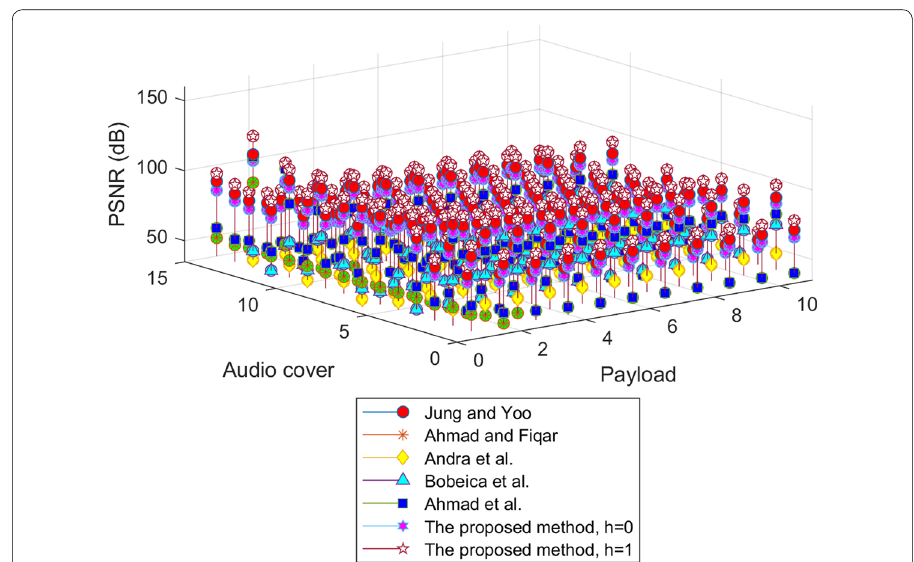
Fig. 9 The quality of the stego file generated by Jung and Yoo [29], Ahmad and Fiqar [30], Andra et al. [32], Bobeica et al. [33], Ahmad et al. [31], and the proposed technique with e = 3 , m = 1 , h = 0 and h = 1